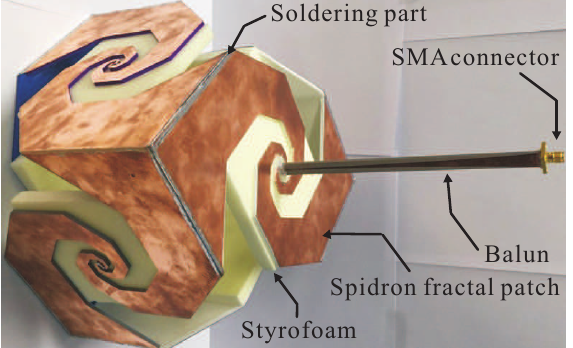
Figure 6. Photograph of the proposed antenna.